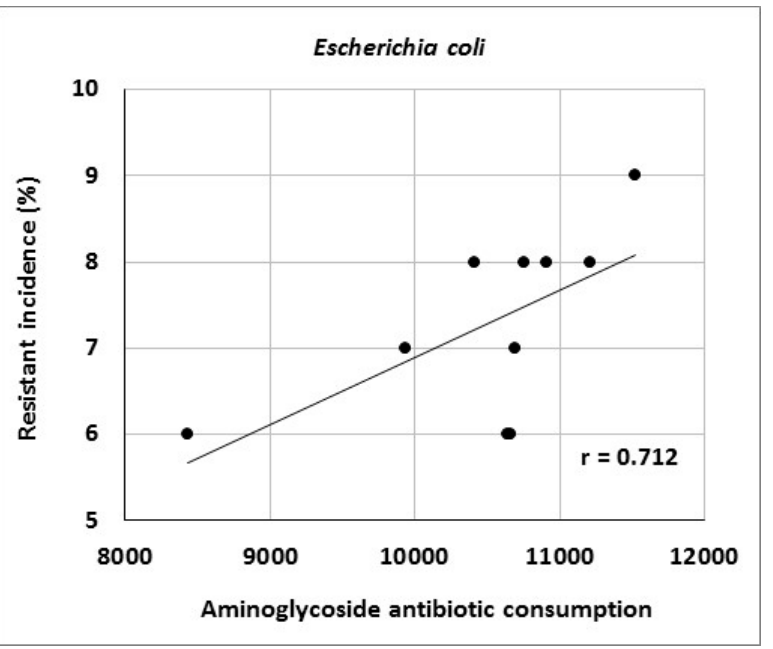
Figure 1. Correlation between aminoglycoside consumption (in numbers of defined daily doses) and resistance of Escherichia coli to gentamicin.